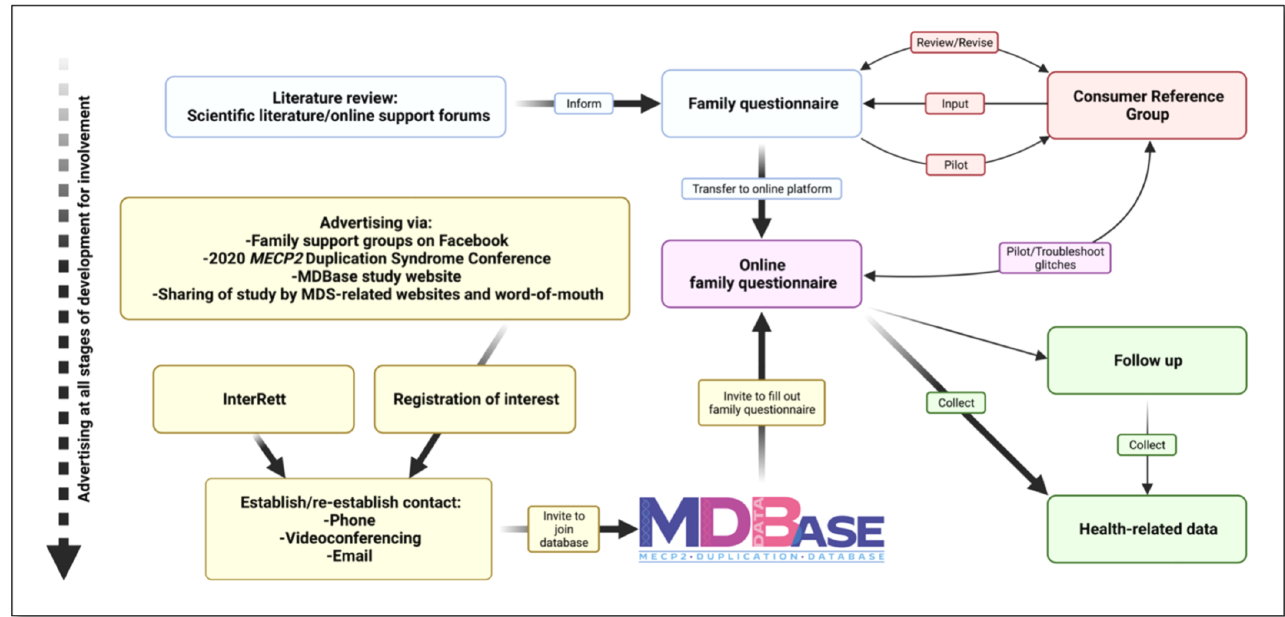
Figure 3. Development of the international MECP2 Duplication Database (MDBase).